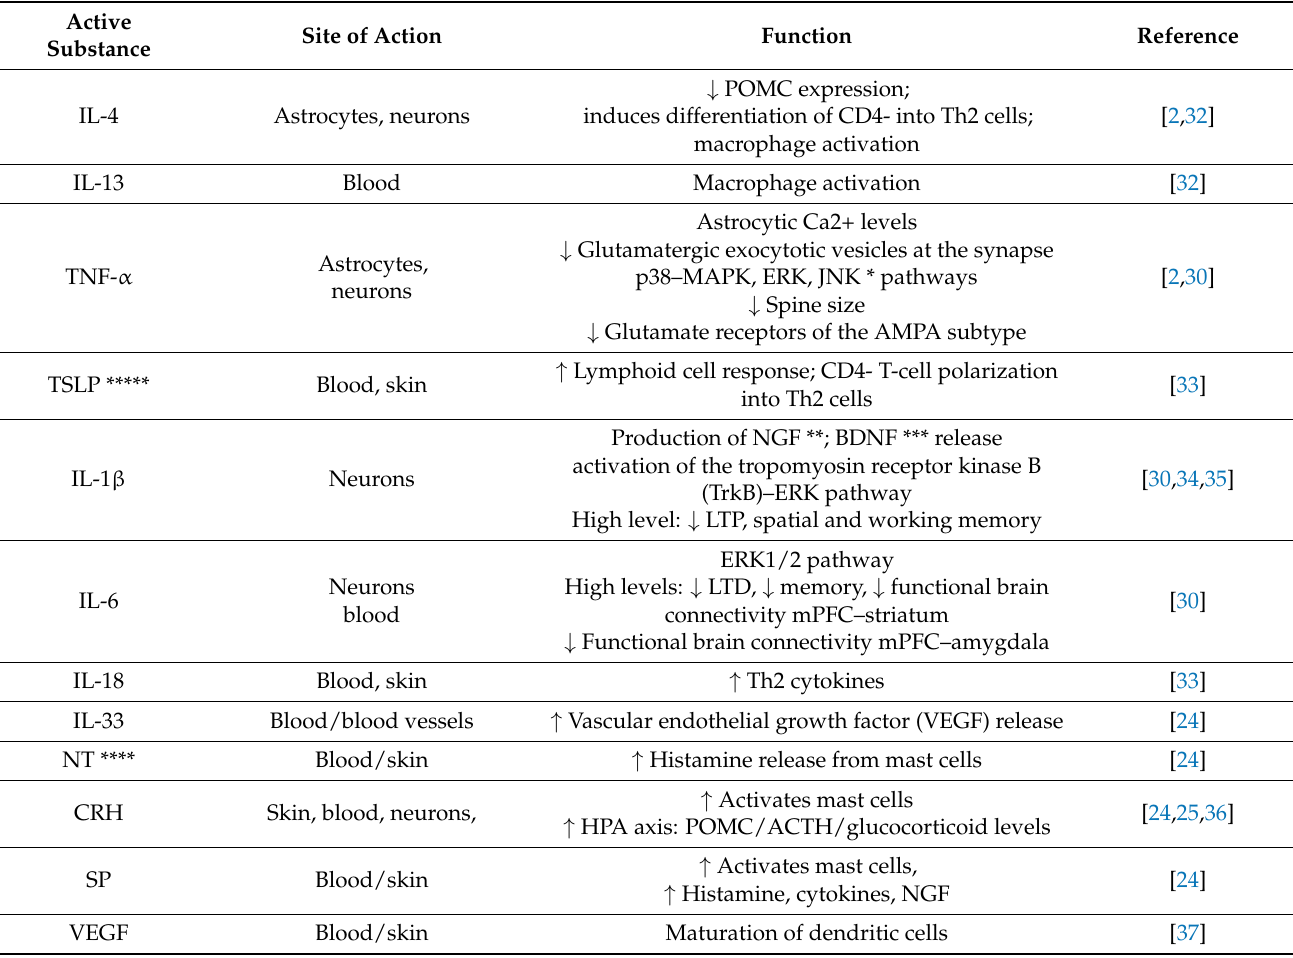
Table 1. Molecular players of the skin–brain axis. Involved cell types and their molecular substrates as well as the mechanism of action of molecular substrates, such as cytokines, along the skin–brain